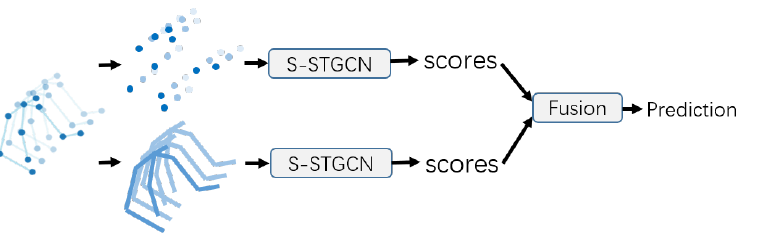
Figure 5. Two-stream network. The two self-attention enhanced spatial temporal graph convolutional networks (S-STGCNs) take the joint information and the bone information as input respectively. The fusion of the outputs of these models are used for final